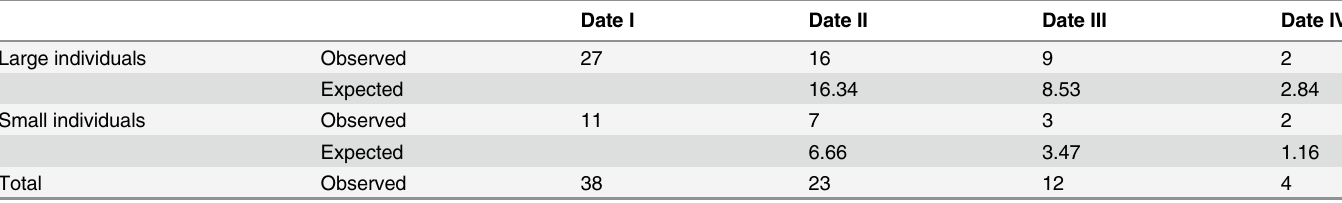
Surviving individuals were counted on each measurement date. Expected numbers were calculated assuming that there is no difference in wash-out rates between large and small individuals. Dates I – IV are de fi ned in the